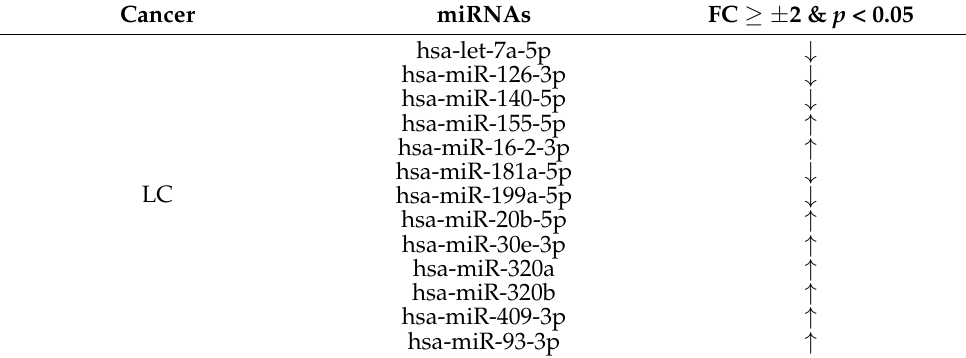
Table 4. List of miRNAs significantly ≥ 2-fold up- or downregulated in trained subjects compared to sedentary subject ( p -value < 0.05) and with diagnostic potential for lung (LC), prostate (PC), colon (CC), liver (HC) and gastro-esophageal (GEC) cancers. The modulation of each miRNA, in trained subjects compared to sedentary subjects, is reported as ↑ (upregulated), ↓